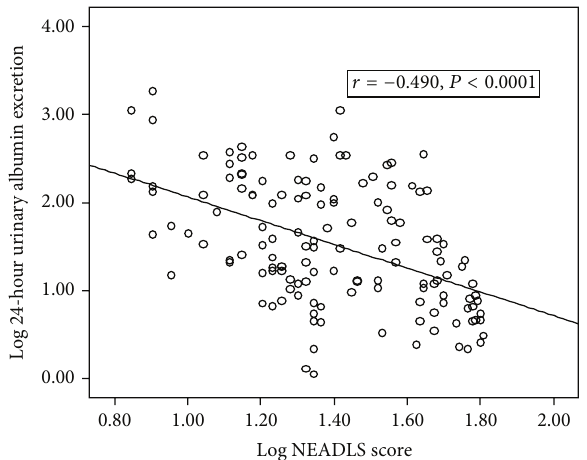
Figure 1: The scatter plot graph between logarithmically converted Nottingham Extended Activities of Daily Living Scale (NEADLS) scoreandlogarithmicallyconverted24-hoururinaryalbuminexcre- tion (UAE).